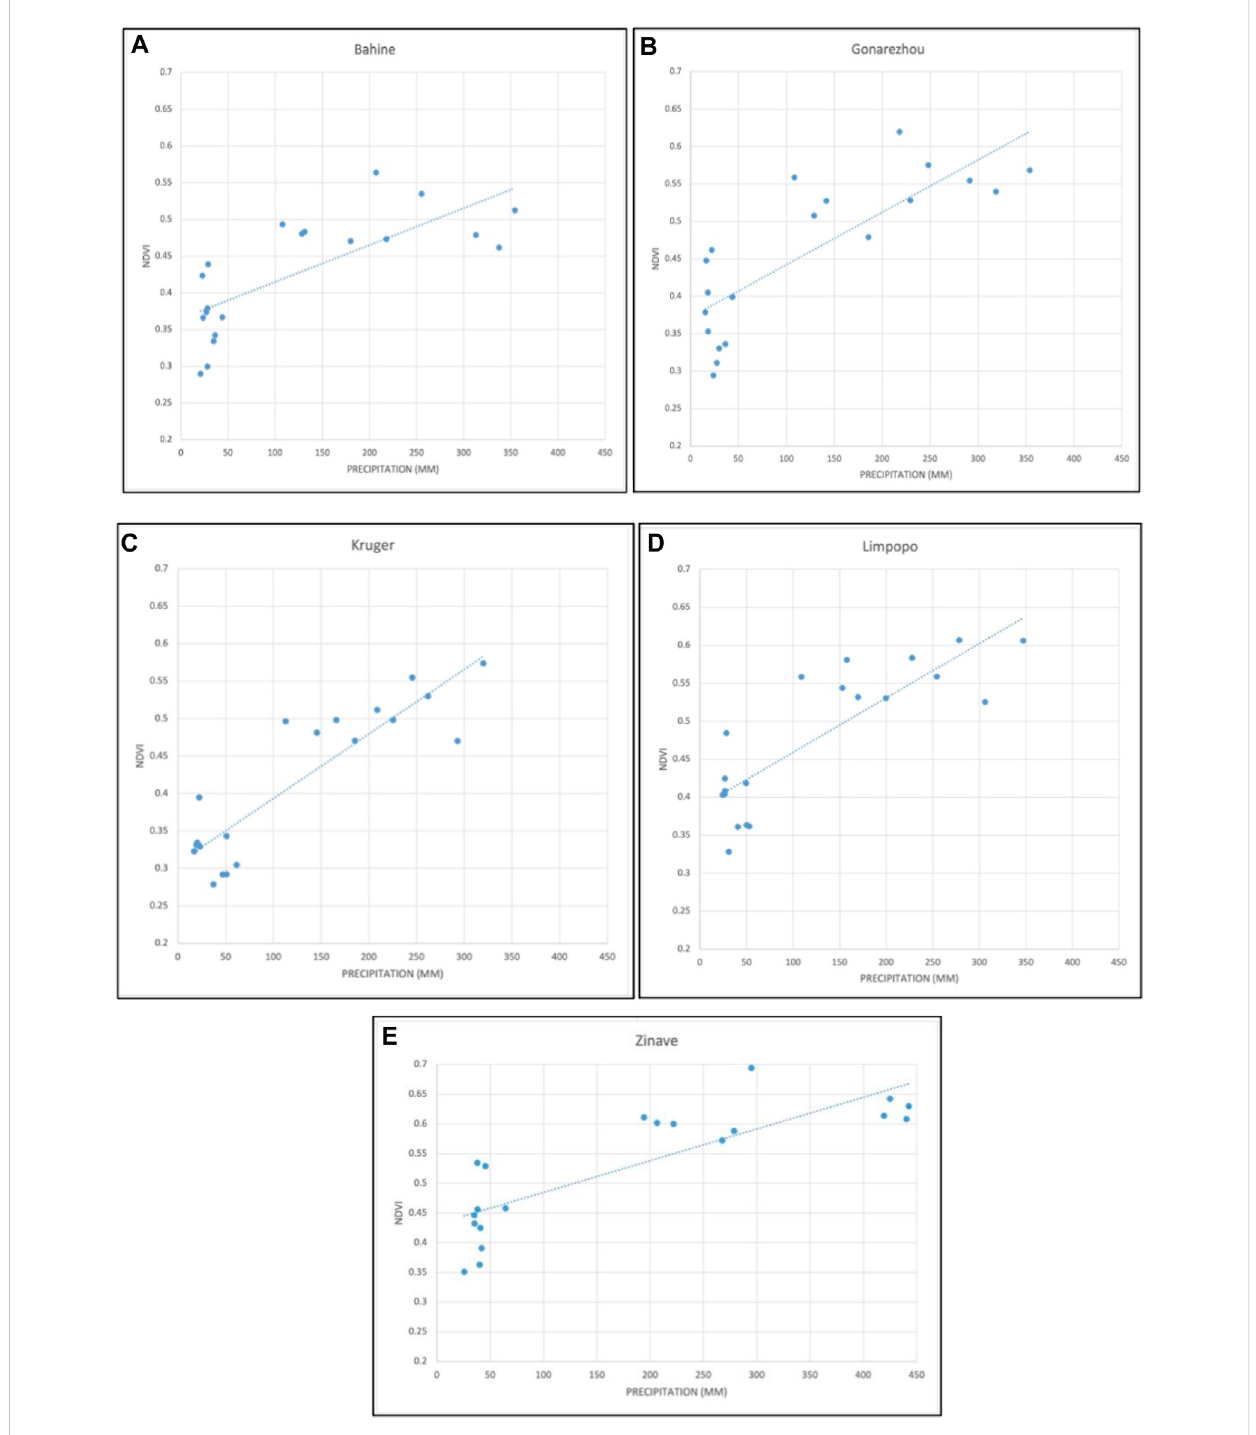
FIGURE 9 Mean Normalized Difference Vegetation Index (NDVI) regressed against total precipitation (mm) from 1999 to 2020 by National Park (A) Bahine (B) Gonarezhou (C) Kruger (D) Limpopo (E)